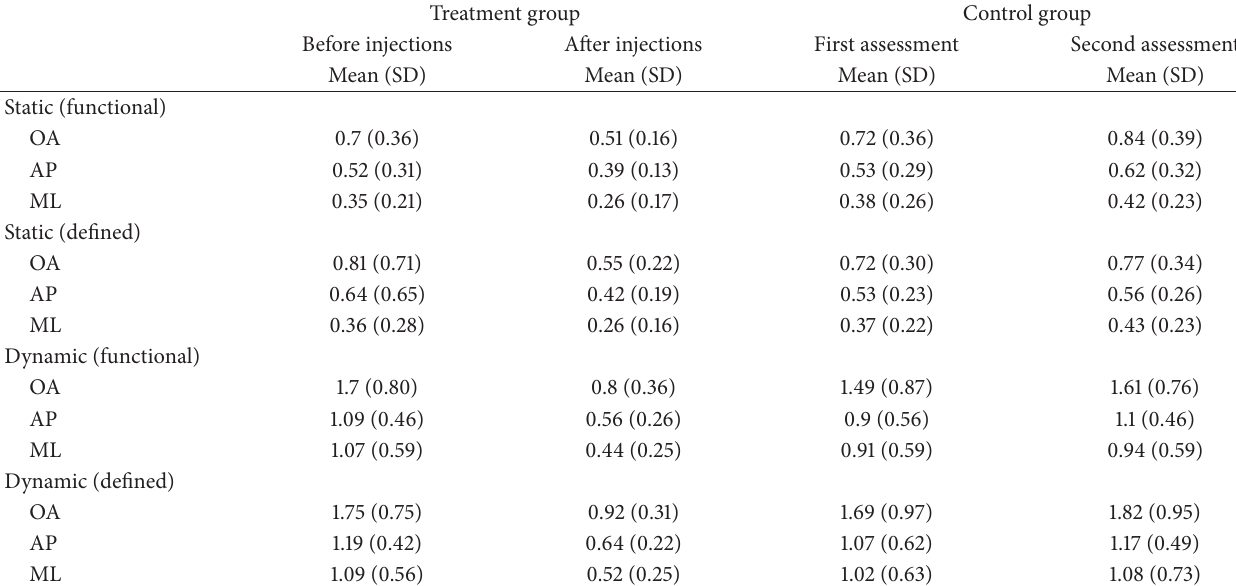
Table 2: Postural stability scores.